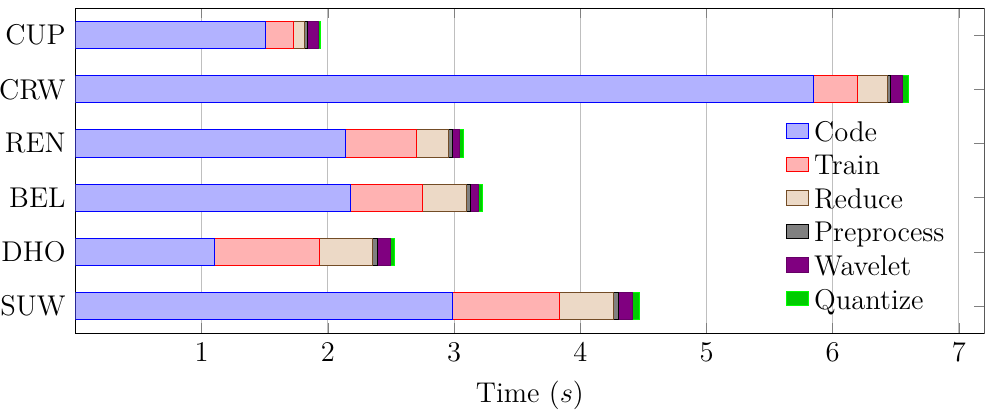
Figure 4. Timing breakdown when compressing a set of hyperspectral images with JYPEC. Steps are sorted by time. While training takes a fair bit of time, coding is clearly the bottleneck of the